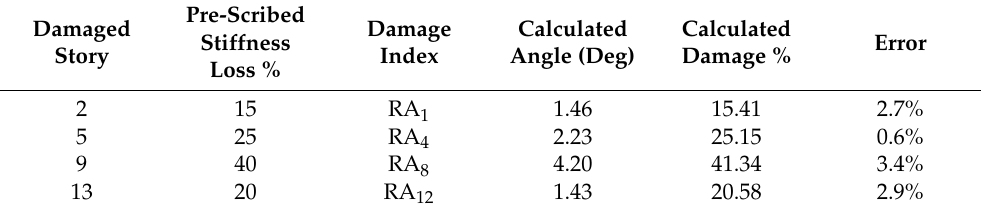
Table 2. Prescribed and calculated damage